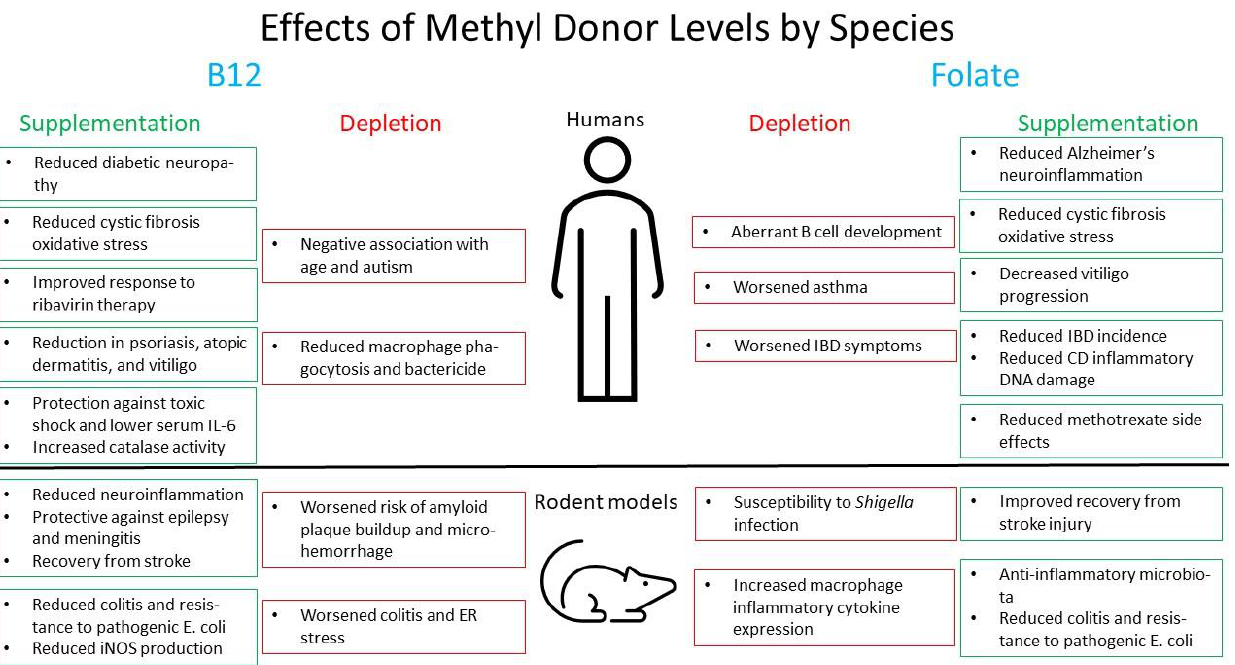
Figure 4. Overview of the effects of folate and B12 supplementation or depletion in humans and rodent models.